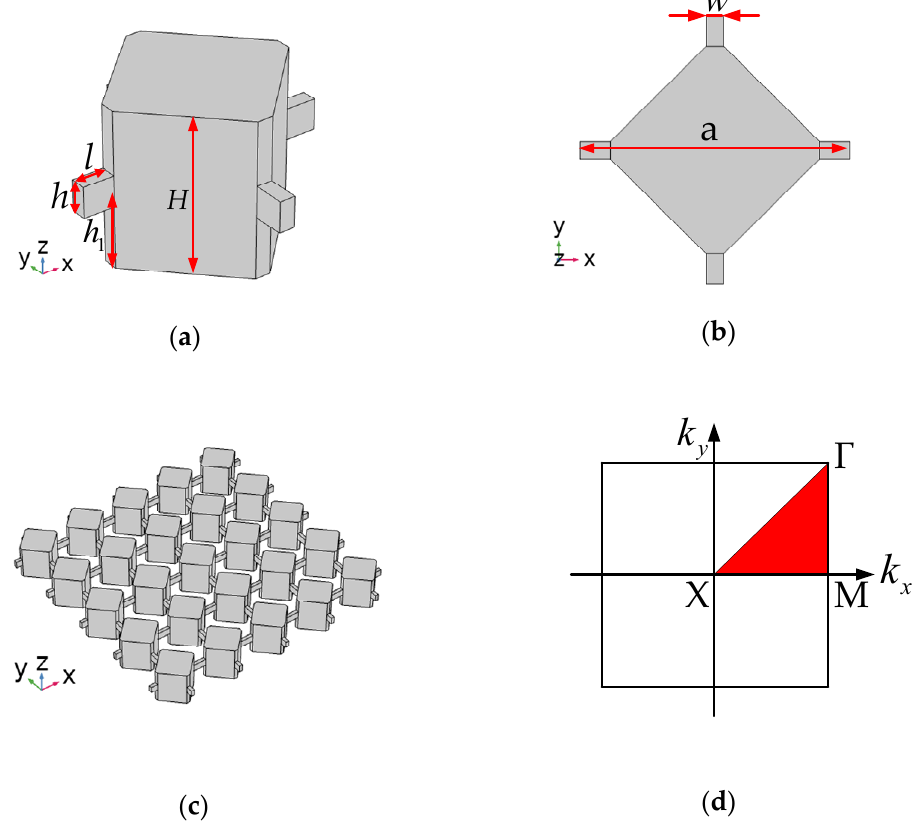
Figure 1. Phononic crystal structure size display: ( a ) the basic 3D model of the phonon crystal; ( b ) the top view of the unit structure; ( c ) a partial structure of the phonon crystal; ( d ) the first Brillouin area of the phonon crystal.